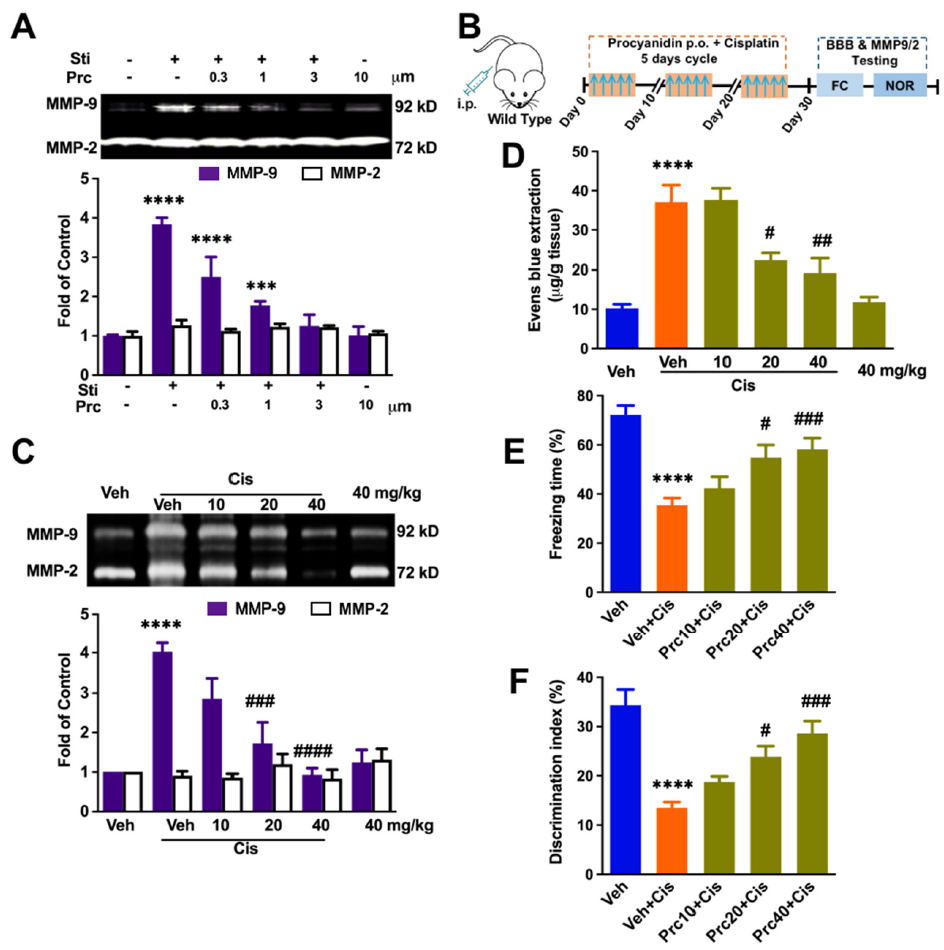
Figure 5. Prophylactic procyanidin dose-dependent rescue of cisplatin-induced increased levels of MMP-9, BBB damage, and cognitive decline. ( A ) Procyanidin suppressed the release of MMP-9 of Raw 264.7 cells induced by the supernatant containing high levels of HMGB1. n = 4. ( B ) Behavior paradigm. ( C ) Procyanidin suppressed the cisplatin-induced increase of MMP-9 in the hippocampus in a dose-dependent manner. n = 4~5. ( D ) Evans Blue extraction showing the effects of procyanidin on the BBB permeability changes. n = 4. ( E ) Procyanidin rescues cisplatin-induced deficiency of freezing score in a dose-dependent manner. n = 8. ( F ) Procyanidin rescues cisplatin-induced deficiency of new object recognition in a dose-dependent manner. n = 8. Difference was revealed following one-way or two-way ANOVA ( p **** < 0.0001, p *** < 0.001 vs. control. p # < 0.05, p ## < 0.01, p ### < 0.001, p #### < 0.0001 vs. cisplatin group. Tukey post hoc tests).